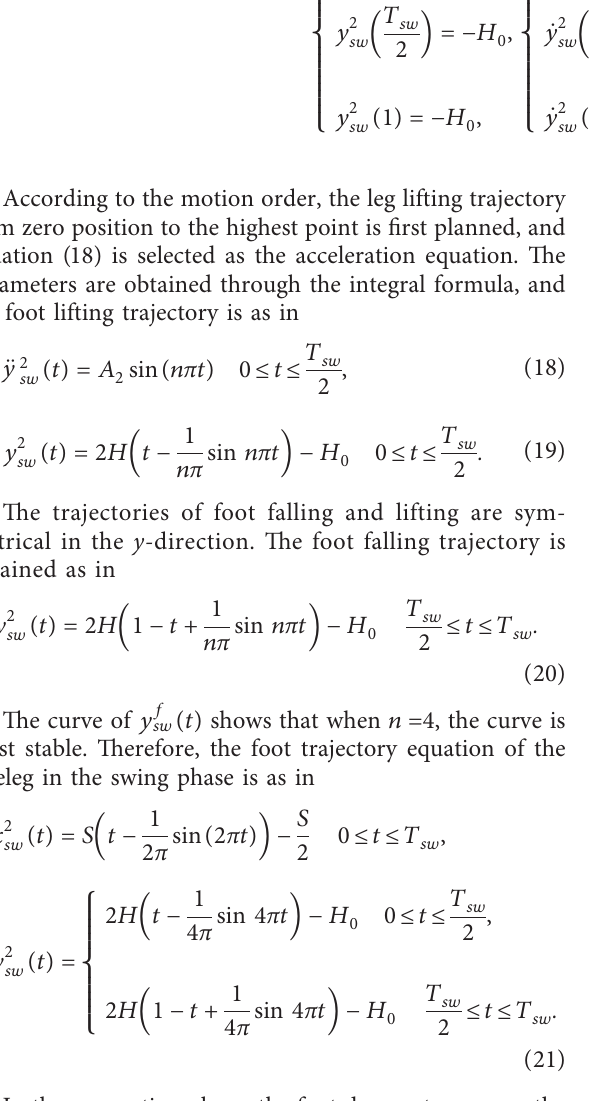
Figure 11. The results show that when the counterweight shifts 120 mm without rotation or falling, the barycenter deviates with the counterweight in the same direction ( x ) and the offset is 100 mm. The lateral ( y ) and vertical ( z ) do not change. However, if the counterweight does not shift, the rotation and vertical motion parameters rotate from 0 ° to 90 ° , and the barycenter of BAM gradually decreases along the z- direction, while no variation in the x- and y-